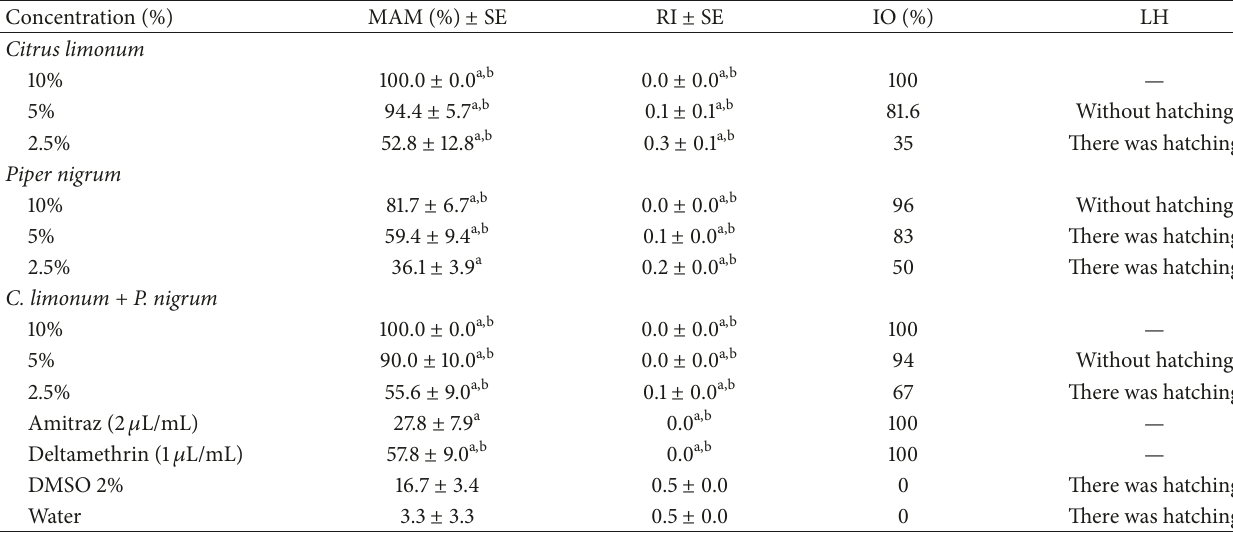
Table 3: Mortality percentage (MAM) of R. microplus engorged females, exposed to different concentrations of Citrus limonum and Piper nigrum , and effect reproductive index (RI), inhibition of oviposition (IO), and larvae hatching (LH). Concentration (%) MAM (%) ± SE RI ± SE IO (%) LH Citrus